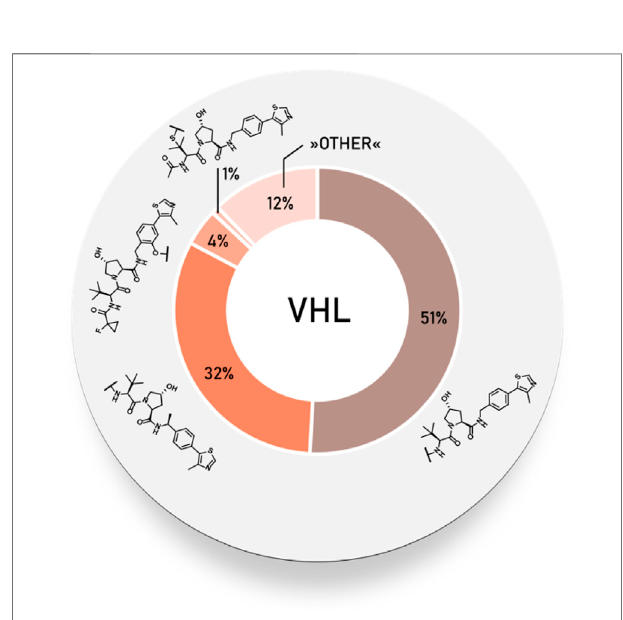
FIGURE 5 | Frequency of VHL ligands used in PROTAC